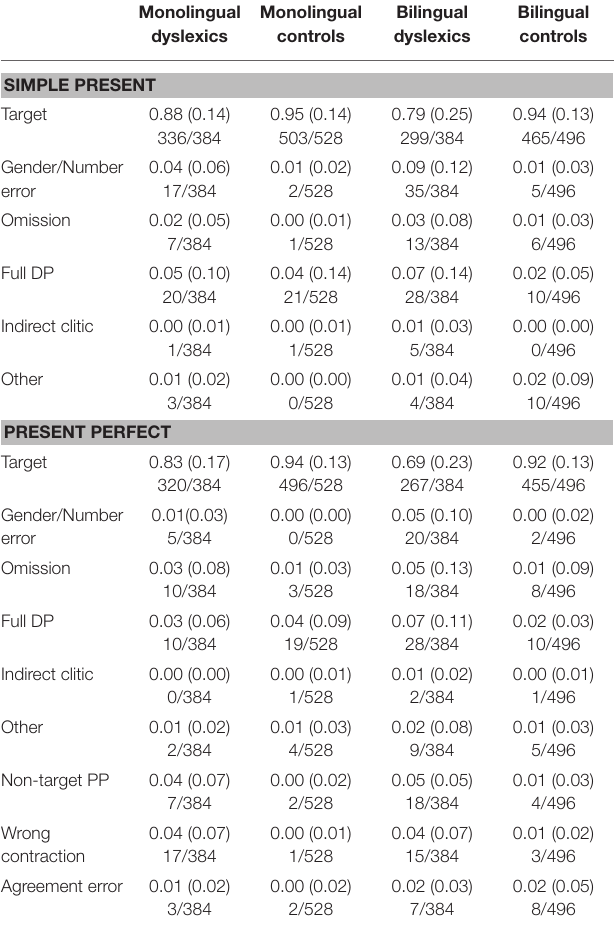
TABLE 5 | Mean (SDs) and Number (N/total score) of responses in the clitic production task for each group. Monolingual Monolingual Bilingual Bilingual dyslexics controls dyslexics